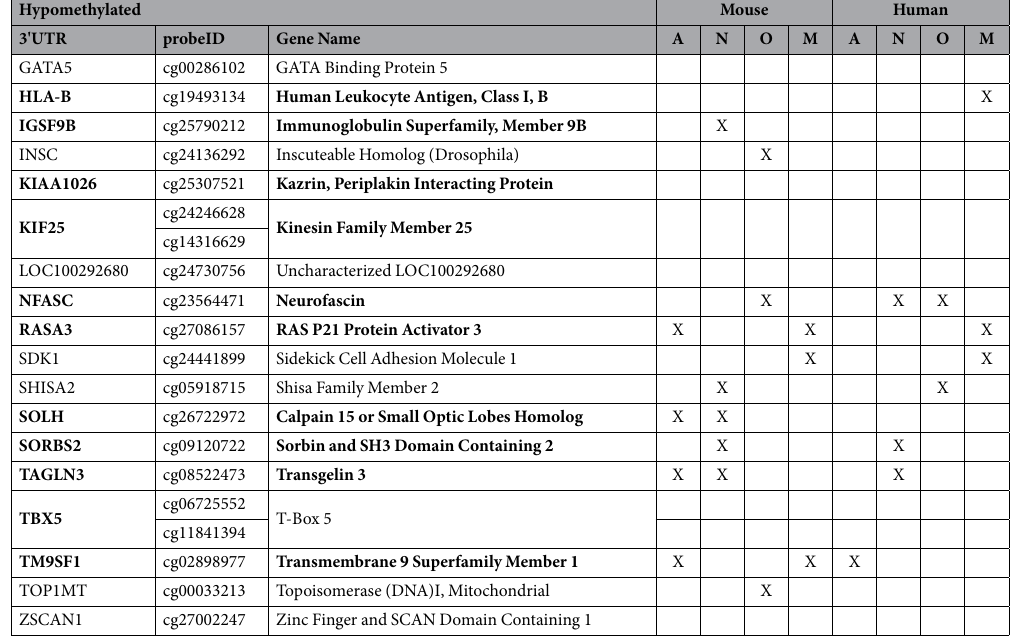
Table 2. Cellular identity of hypo- and hyper-methylated CpG target genes identified in MS hippocampus following demyelination. Identified genes were mapped to astrocytes (A), neurons (N), oligodendrocytes (O), or microglia/macrophage lineage (M) cells in mouse and human CNS cell-specific database 25, 26 . To increase confidence in cellular identity, matching genes showing expression levels above the 50 th percentile were